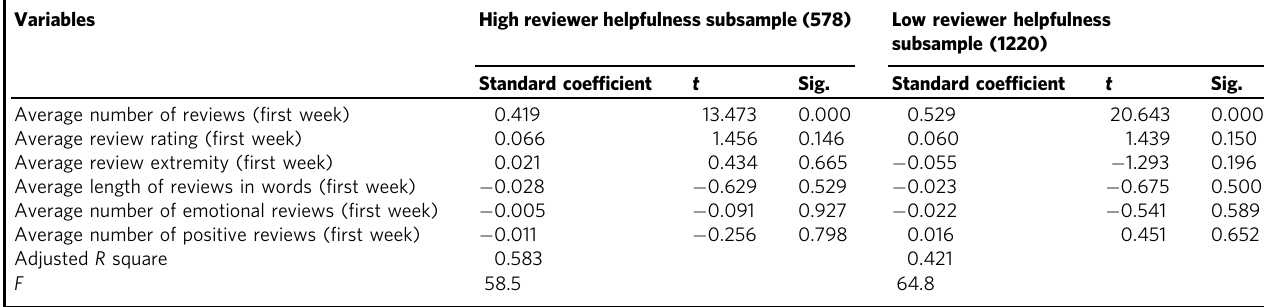
Table 7 Regression analysis for box of fi ce revenue for the second week after release using reviewer helpfulness subsample.